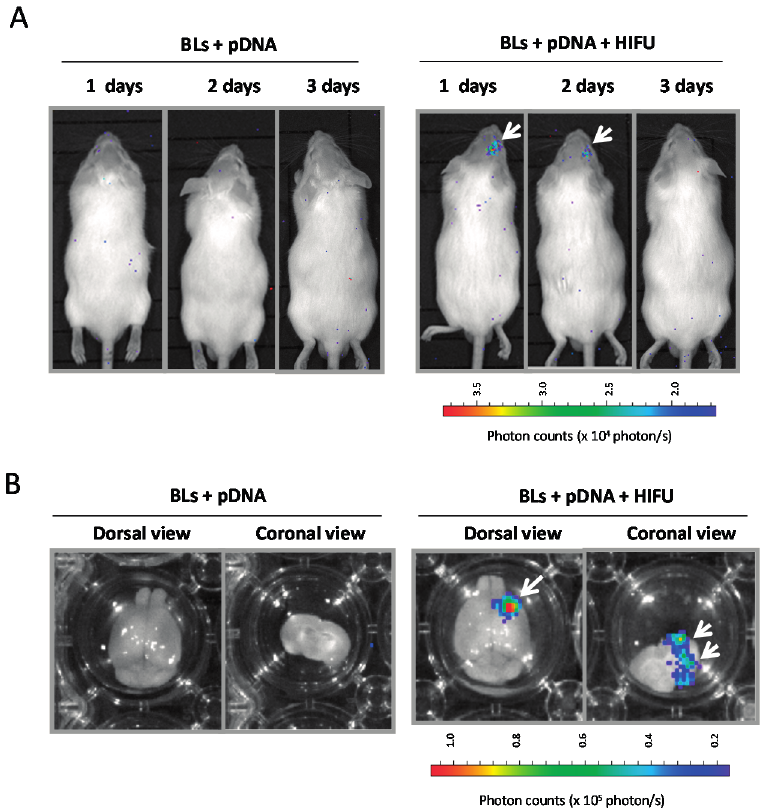
Figure 8. In vivo luciferase imaging after the delivery of plasmid DNA into brain using a combination of BLs and HIFU exposure. ( A ) In vivo luciferase imaging over three